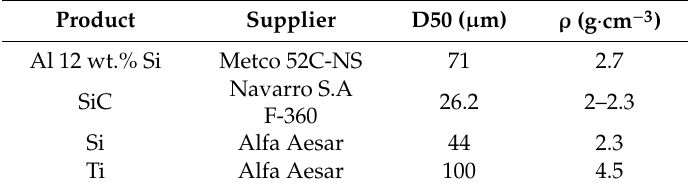
Table 1. Powders properties and suppliers.